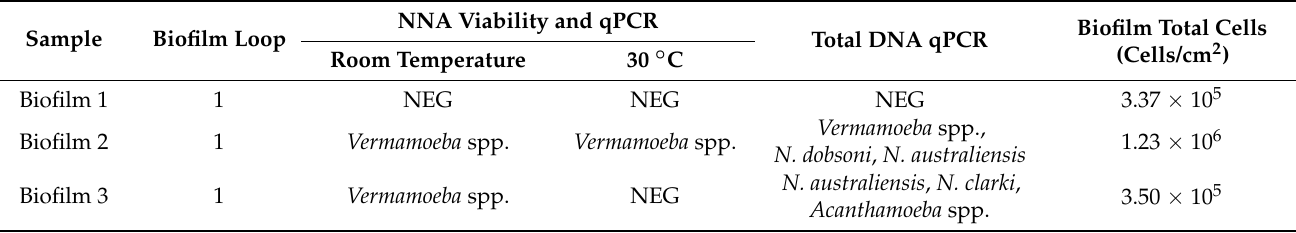
Table 2. Amoebae analysis and total cells in biofilm cells from samples at day